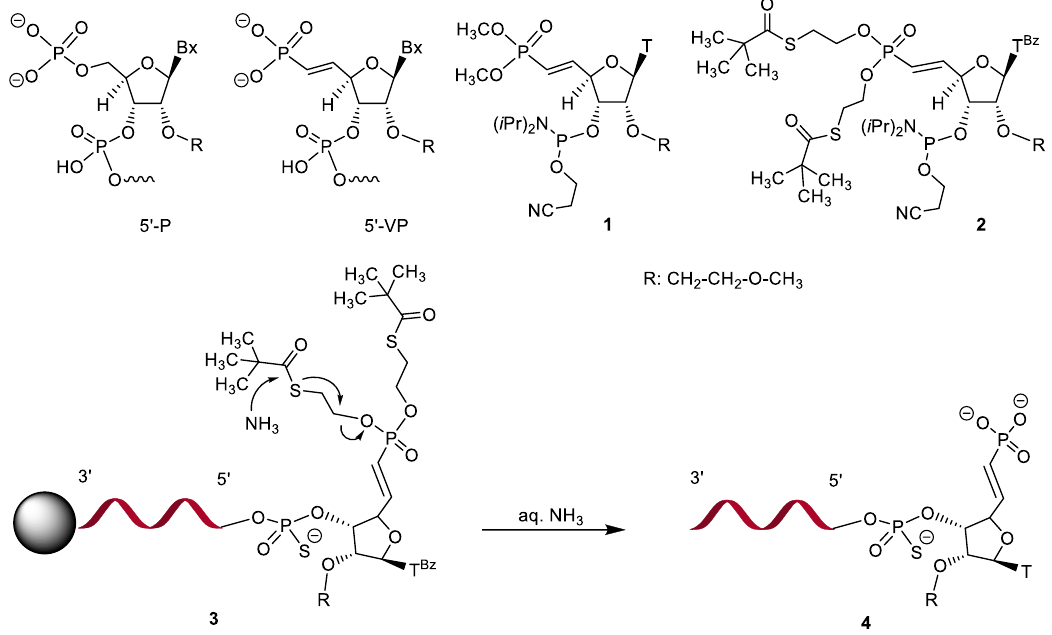
Figure 1. Structure of 5 ′ -phosphate (5 ′ -P), ( E )-5 ′ -vinylphosphonate (5 ′ -VP), 5 ′ -deoxy-( E )-5 ′ -vinyl phosphonate-2 ′ - O -(2-methoxyethyl)-thymidine-3 ′ -phosphoramidite bearing methyl 1 and t Bu-SATE 2 phosphonate esters; proposed mechanism ( 3 and 4) for aqueous ammonia assisted deprotection of t Bu-SATE protecting group.